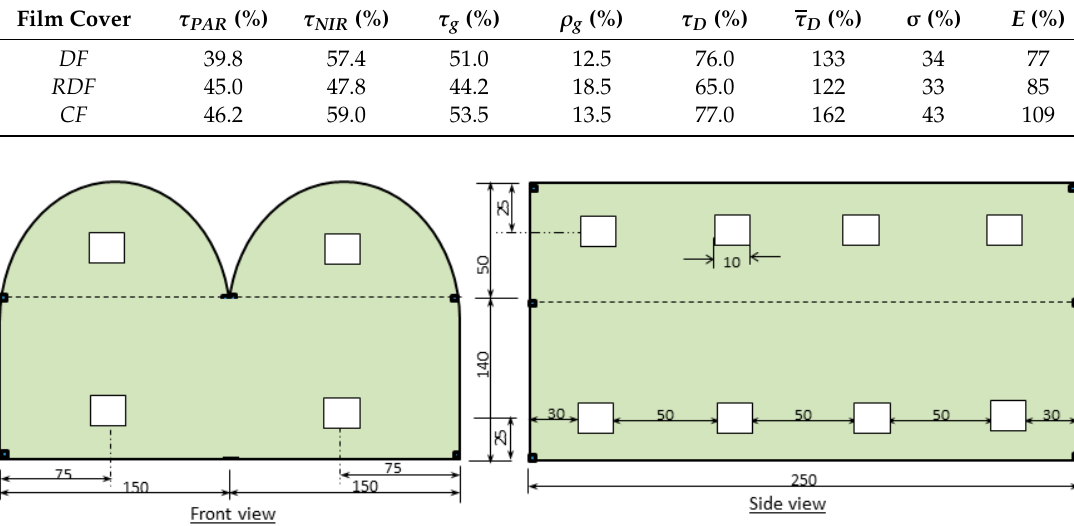
Figure 3. Schematic diagram showing the naturally ventilated twin-span greenhouse model, covered with a plastic film, used for the study; dimensions are in cm, not to scale.